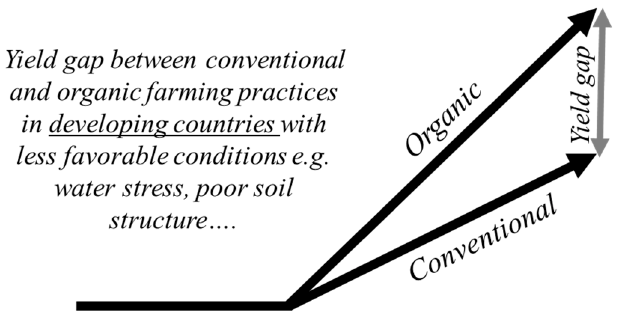
Figure 3. The gap between conventional and organic yield may go into reverse under less favorable